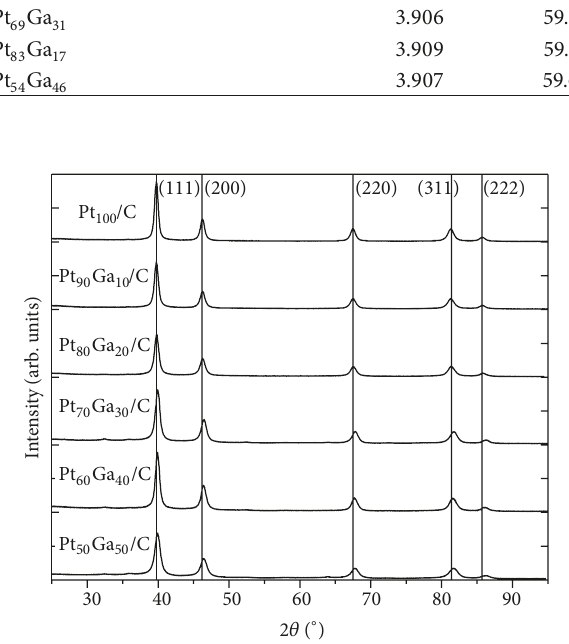
Figure 3: XRD pattern of Pt-based electrocatalysts prepared through thermal decomposition of polymeric precursors method obtained with CuK 𝛼 radiation ( 𝜆 = 1.5406 ˚A) and step rate = 0.01 ∘ min −1